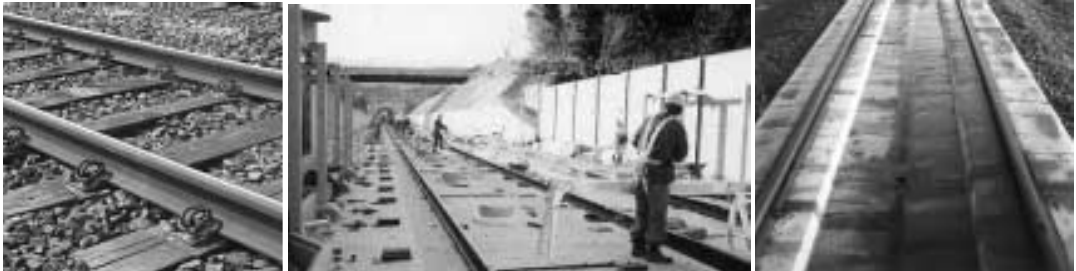
Figure 7. From left to right: Ballasted Track, Shinkansen Slabs, and Embedded